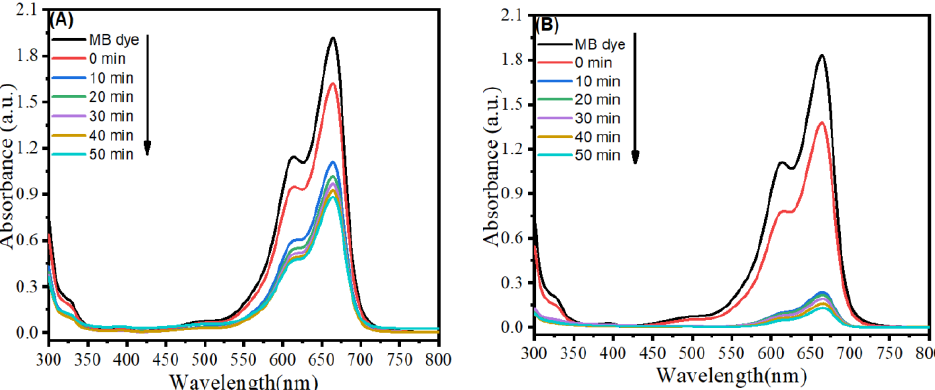
Figure 10. UV–Vis absorbance spectra for the degradation of the MB dye at different time intervals under UV irradiation: SnO 2 NPs ( A ); SnO 2 -rGO NCs ( B ).